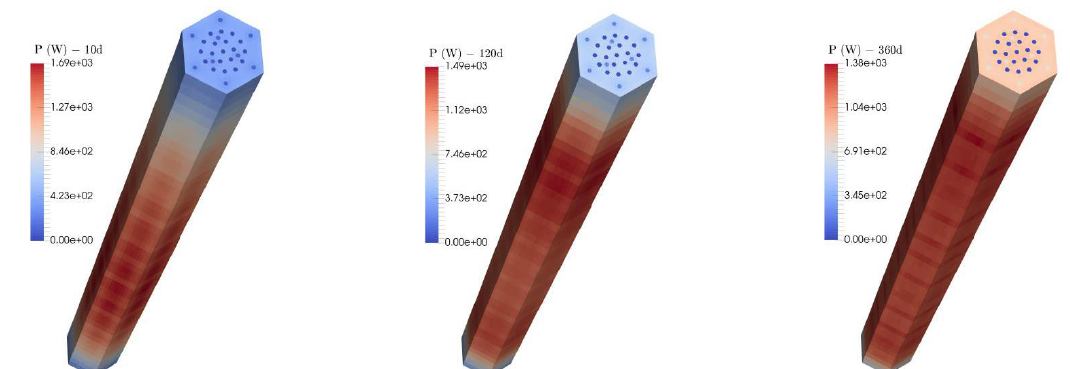
Figure 4: 3D power distribution per pin predicted by